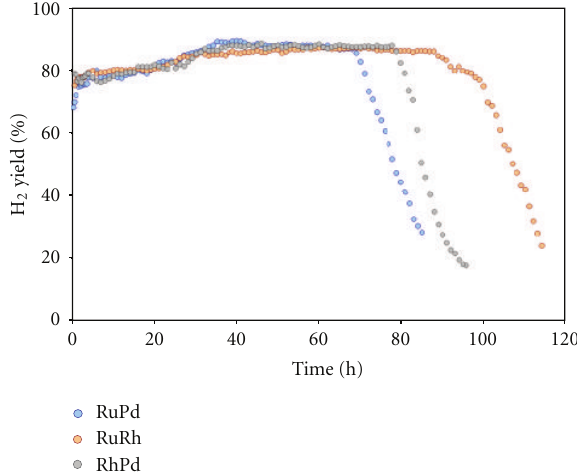
Figure 8: Performance of bimetallic catalysts in terms of hydrogen